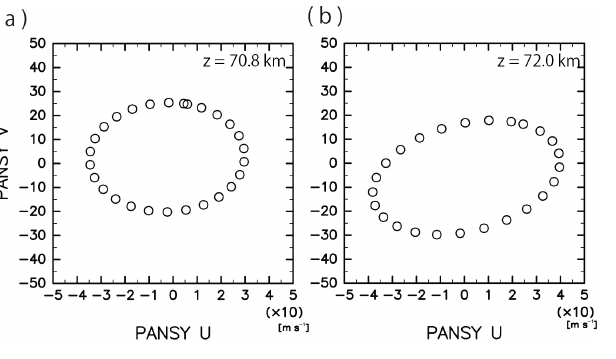
Figure 5. A hodograph of the fitted horizontal wind components in the time region from 00:00UTC to 13:00UTC, 23 March, at the height of (a) 70.8km and (b) 72.0km from the PANSY radar obser- vation. Each mark is plotted at one hour